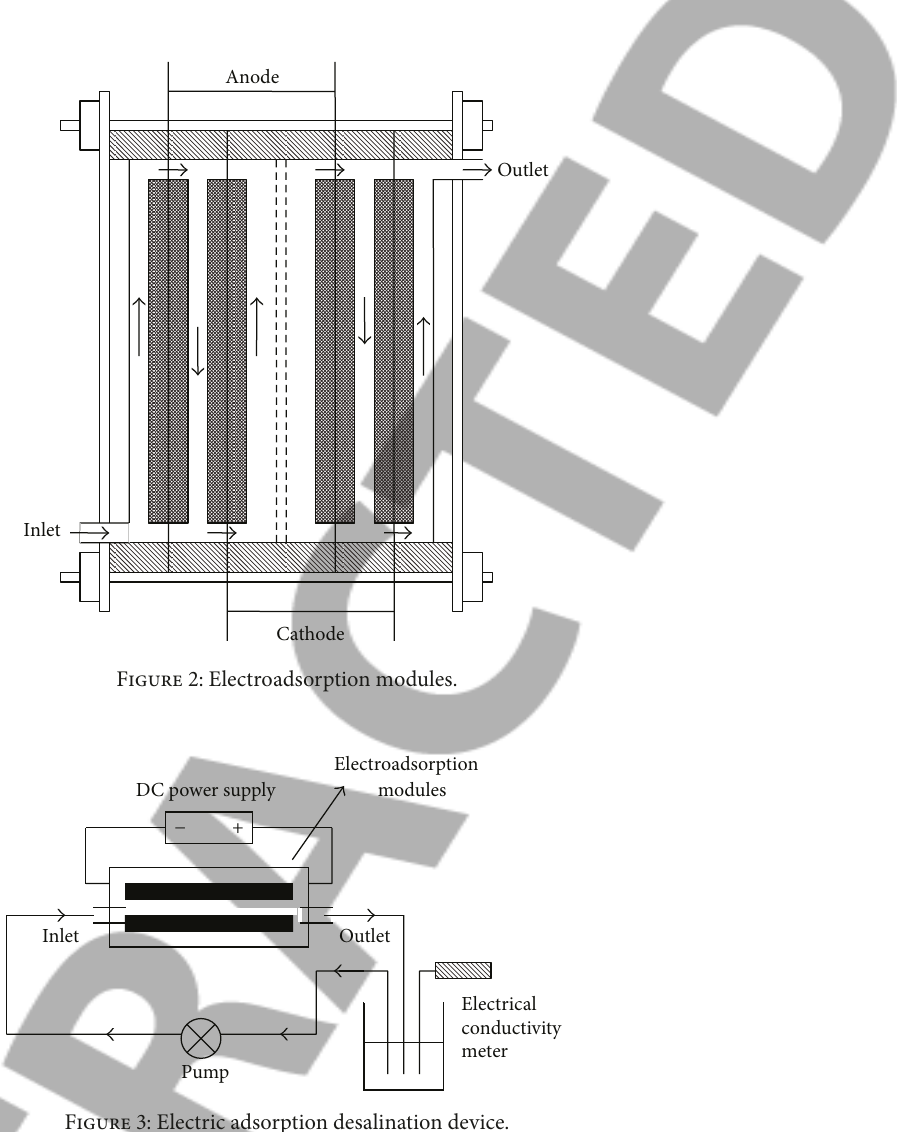
Figure 3: Electric adsorption desalination device.